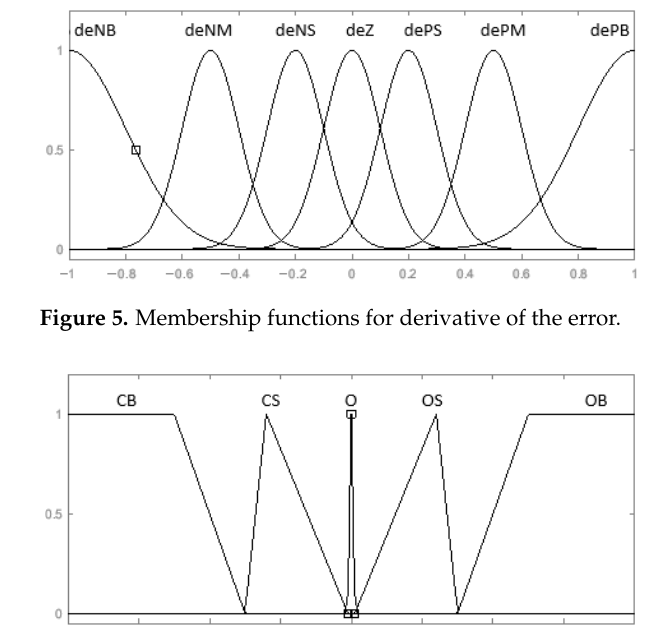
Table 2. Inference rule bases for FLC.